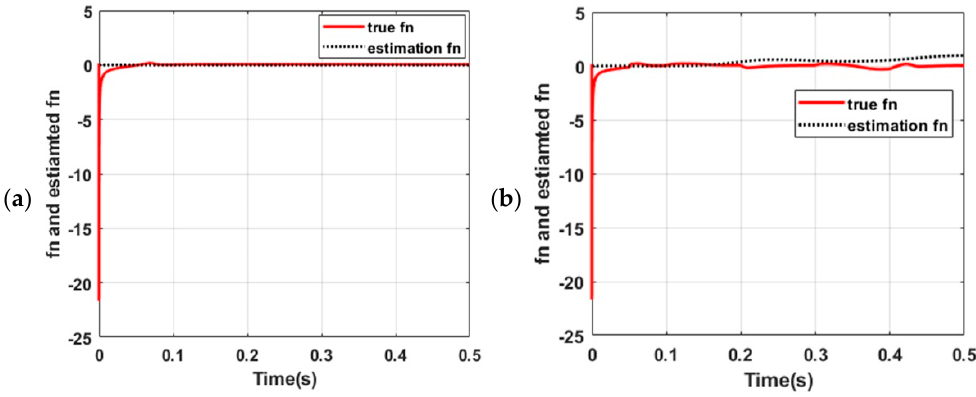
Figure 6 . f n and its estimate. ( a ) Non-interference signal. ( b ) C-level road surface.